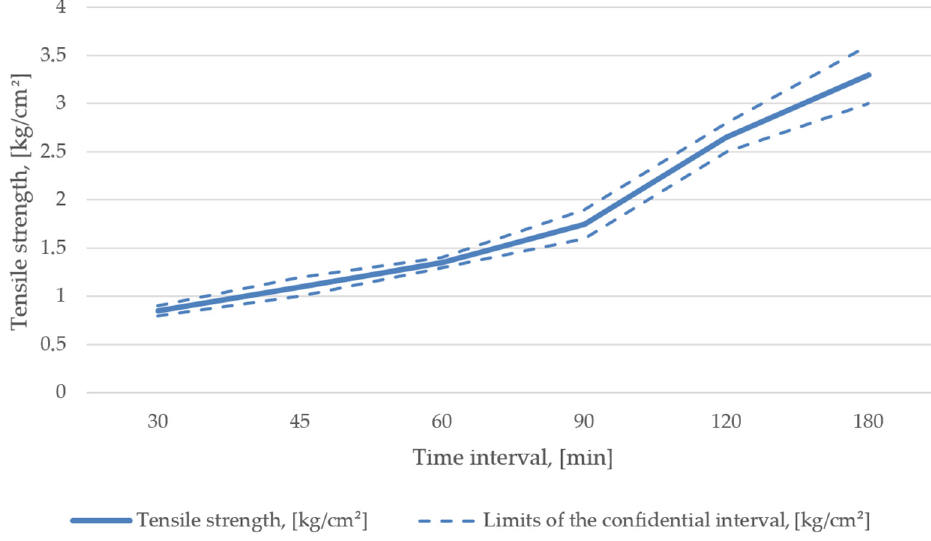
Figure 5. Mechanical properties of the mixture alternative No. 2.